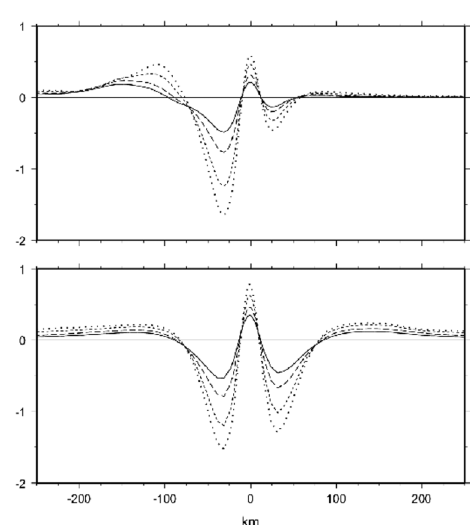
Fig. 4. Postseismic relaxation for the 2D approxi- mation of the CF for both the lateral heterogeneous (top panel) and the homogeneous (bottom panel) model. The four lines depict vertical deformation at four different times after the earthquake: t = 1 a (sol- id), 2 a (long dashed), 5 a (short dashed) and 10 a